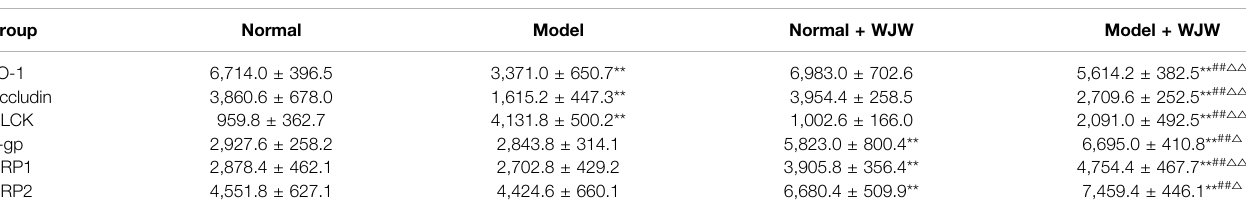
TABLE 5 | The expression of ZO-1, Occludin, MLCK, P-gp, MRP1, and MRP2 in the rats colon ( n = 5, (cid:1) x ± s, AIOD). Group Normal Model Normal + WJW Model +